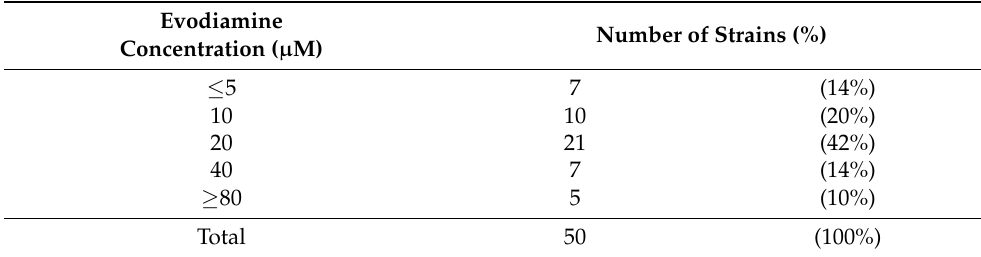
Table 1. MIC of evodiamine on H. pylori clinical